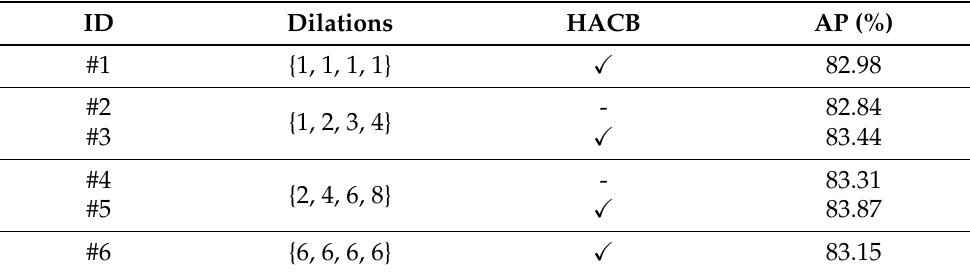
Table 4. Detailed ablation studies on the dilation rates and the hierarchical-atrous convolution block (HACB) of HASP. The item “-” in the table indicates replacing HACB with standard atrous